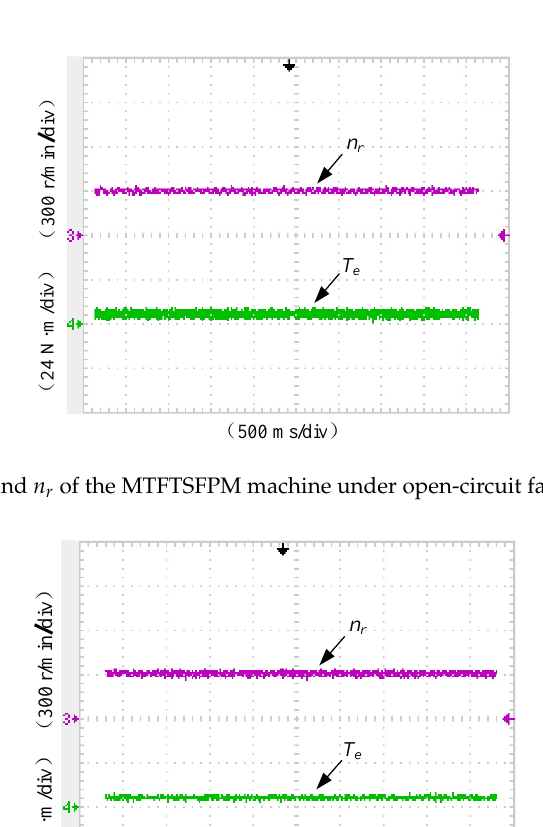
Figure 18. T e and n r of the MTFTSFPM machine under open-circuit fault using RDTC.